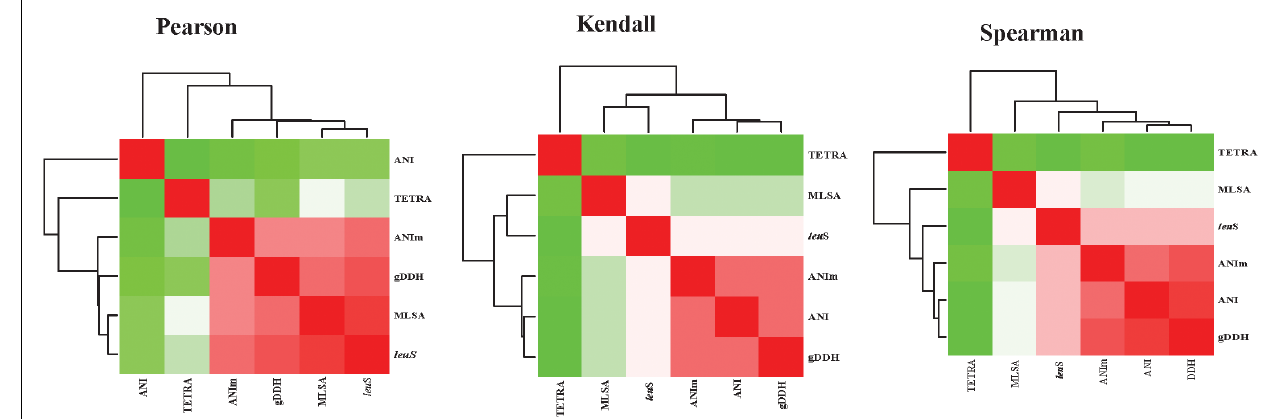
FIGURE 5 | Heatmaps of the correlation coefficients between the different parameters [leuS, Multilocus sequence analysis (MLSA), Average nucleotide Identity (ANI), MuMmer-based average nucleotide identity (ANIm), and genome-based DNA-DNA hybridization (gDDH)]. Correlation analyses were performed using the cor function and visualized using corrplot as implemented in R-Statistics (R Core Team,